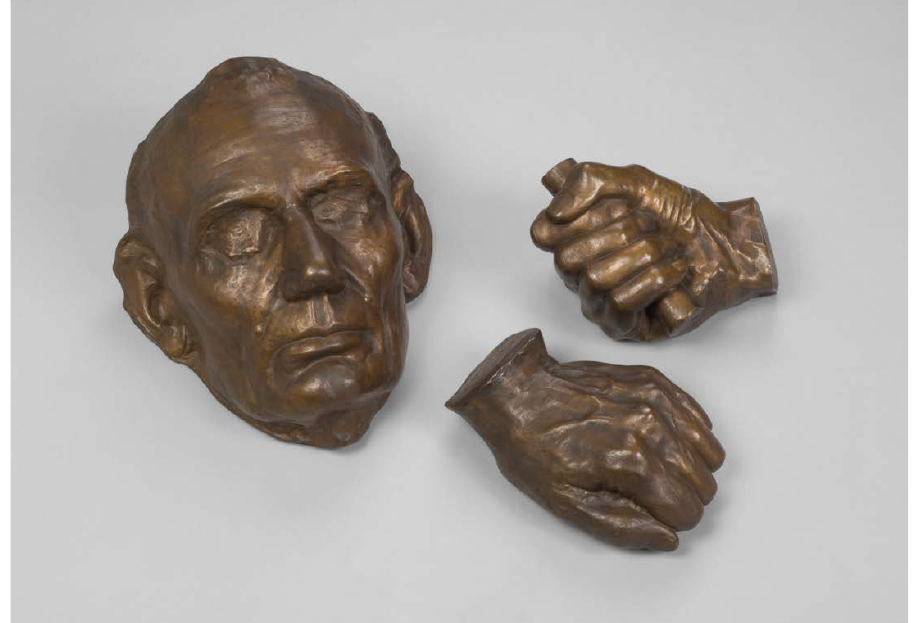
Figure 4 Casts of the Face and Hands of Abraham Lincoln, original Plaster made by Leonard Wells Volk (American, 1828–1895) in 1860, bronze made under the direction of Augustus Saint-Gaudens (American, born Ireland, 1848–1907) in 1886. Face: 8 3/8 x 7 5/8 x 5 1/2 inches (21.3 x 19.4 x 14 cm) Right hand: 6 1/4 x 4 7/8 x 3 3/8 inches (15.9 x 12.4 x 8.6 cm) Left hand: 6 5/8 x 4 3/8 x 2 1/2 inches (16.8 x 11.1 x 6.4 cm). Gift of the Fairmount Park Art Association,